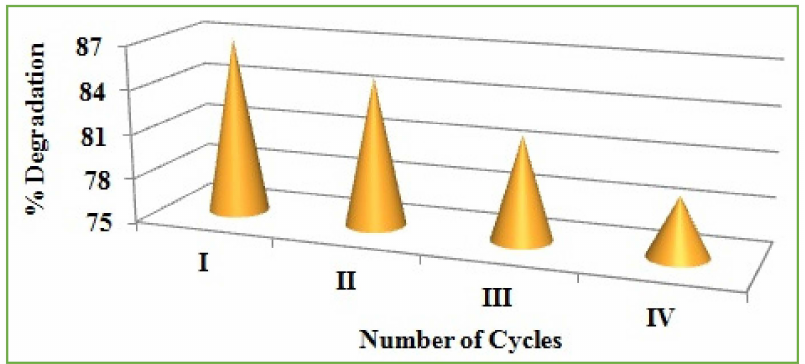
Figure 14. Reusability of catalyst for methylene blue